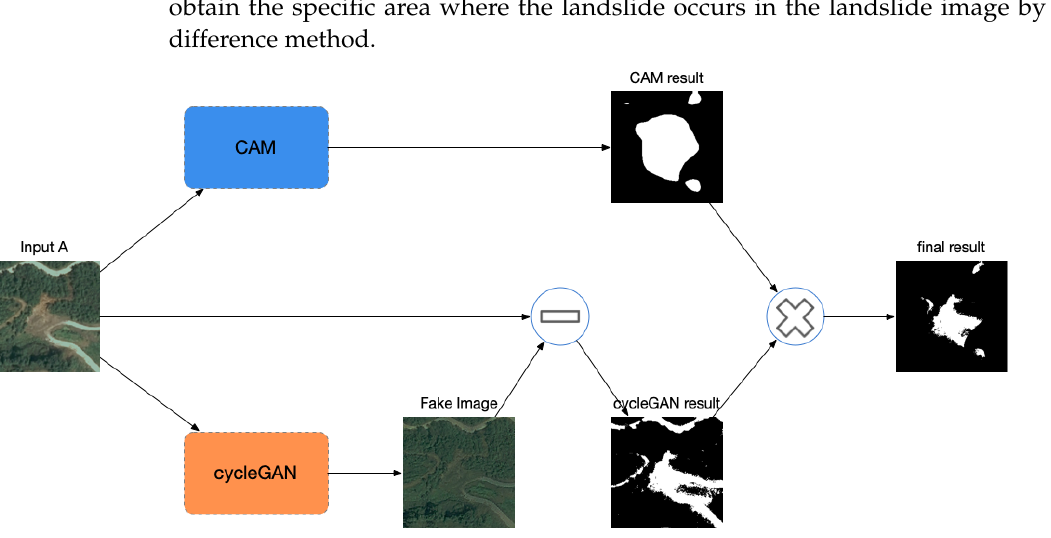
Figure 4. Flowchart combining CAM and cycleGAN methods.